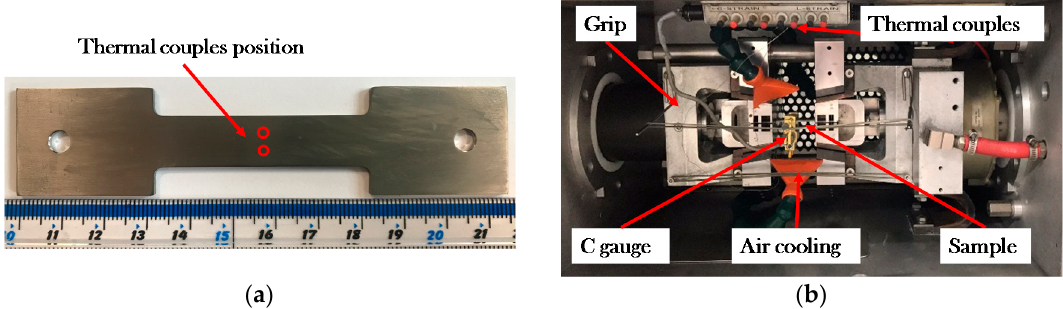
Figure 3. Experimental set-up ( a ) thermocouple location, and ( b ) hot tensile test set-up.